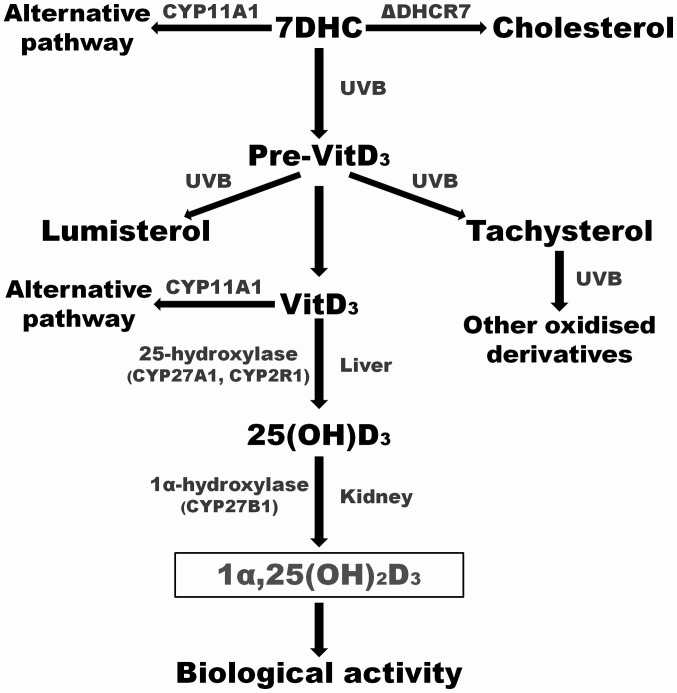
Synthesis, activation and metabolism of vitamin D3.